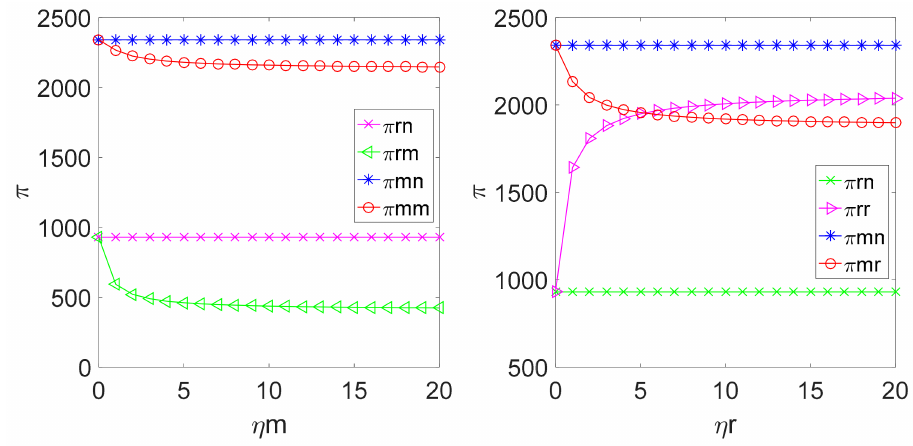
Figure 6. Relationship among η m and η r .